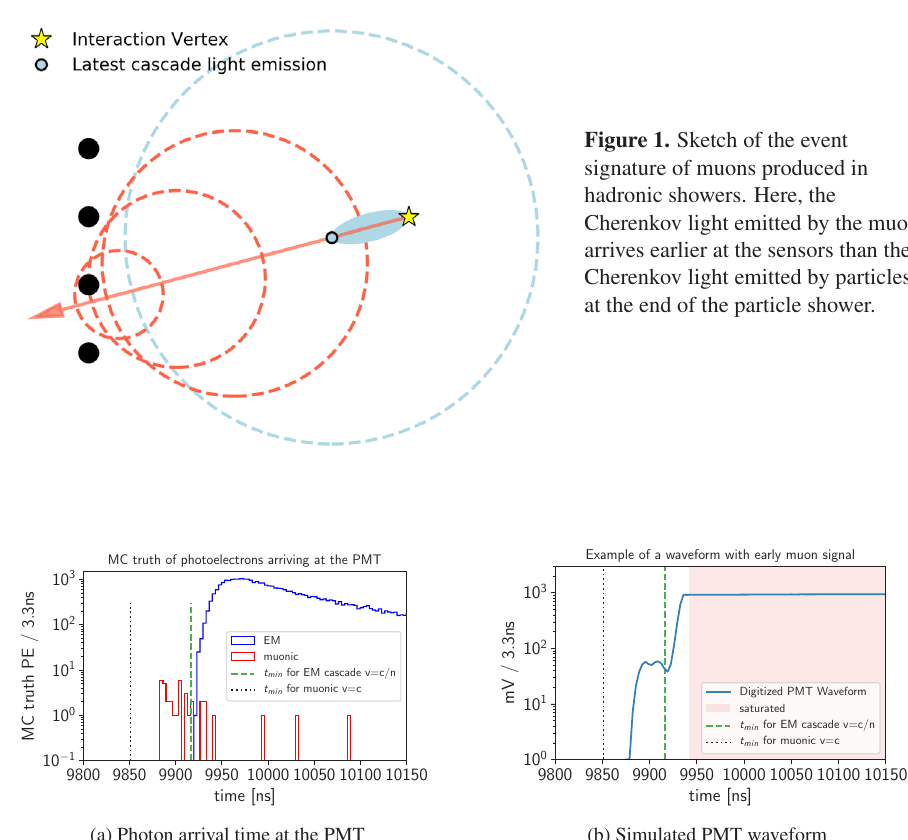
Figure 2. Early muon signal in a PMT close to the event vertex. Black and green dashed lines indicate the muon and shower light fronts